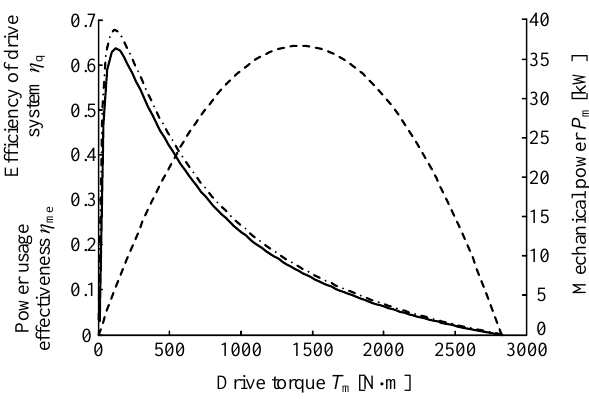
Figure 6. Test result of drive system experiment.